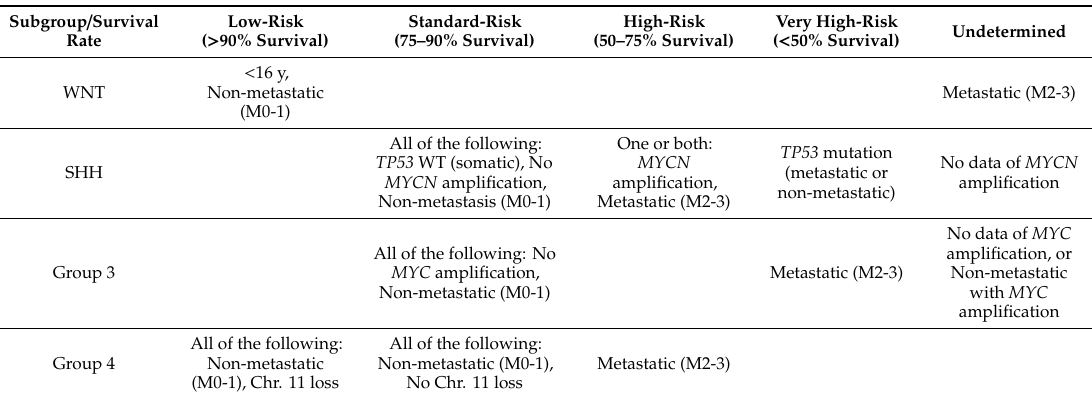
Table 2. Adjusted Heidelberg risk stratification scheme for survival analysis at all ages of the 52 childhood MBs in a cohort series in